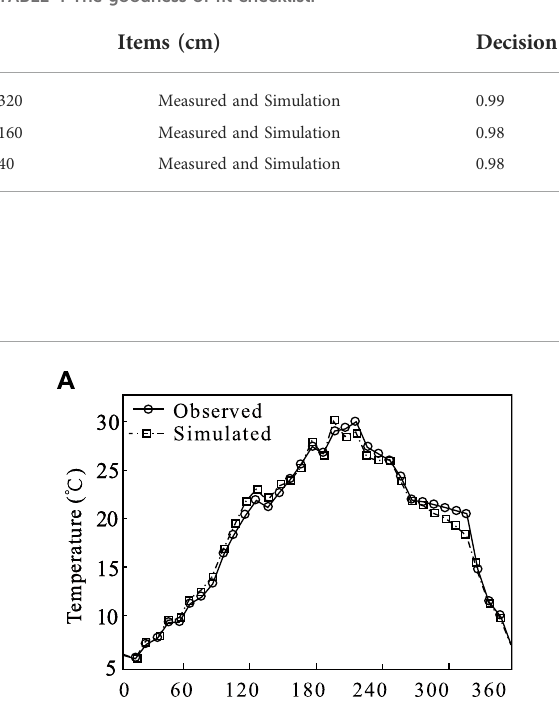
FIGURE 6 Process line of aquifer temperature change near mining well of